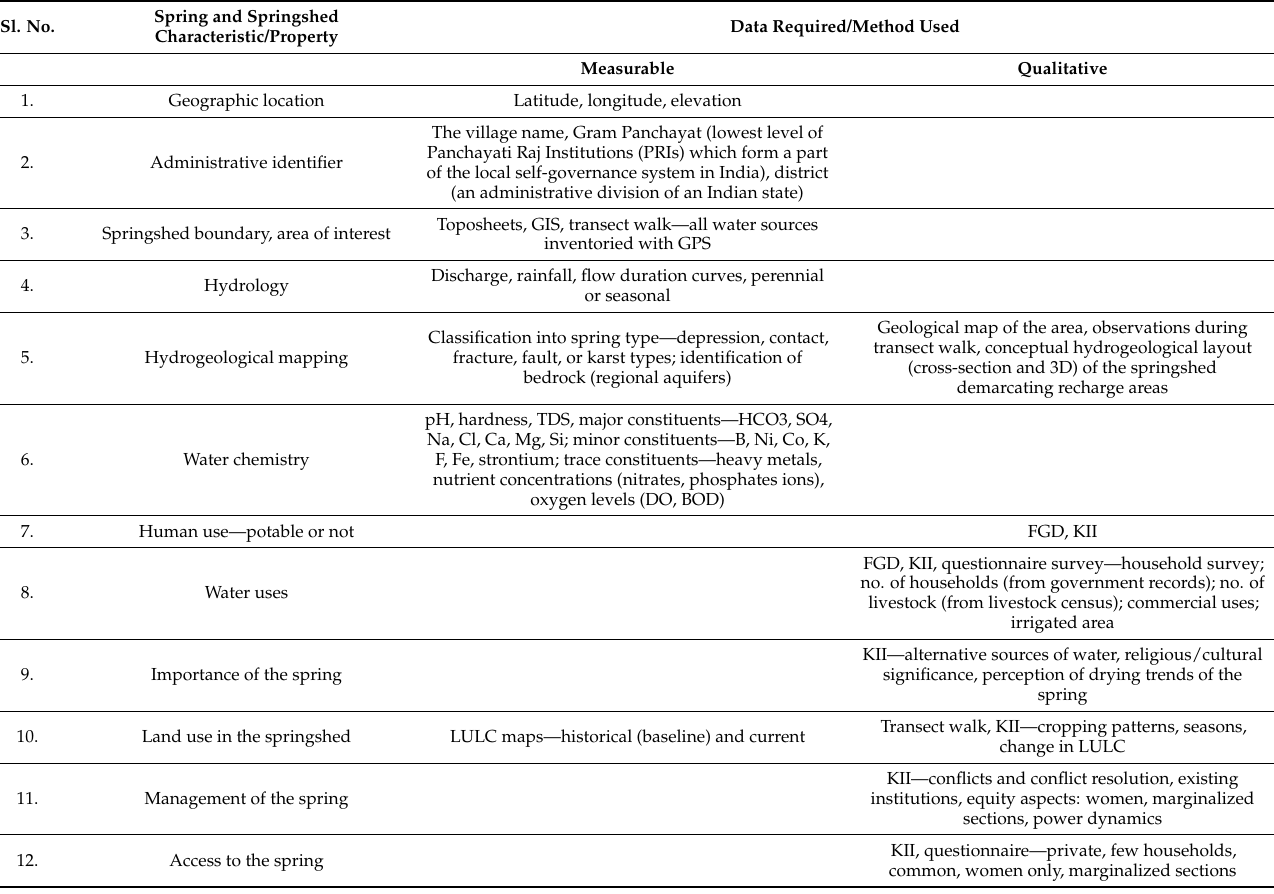
Table 3. Data requirements for identifying the type of springs.